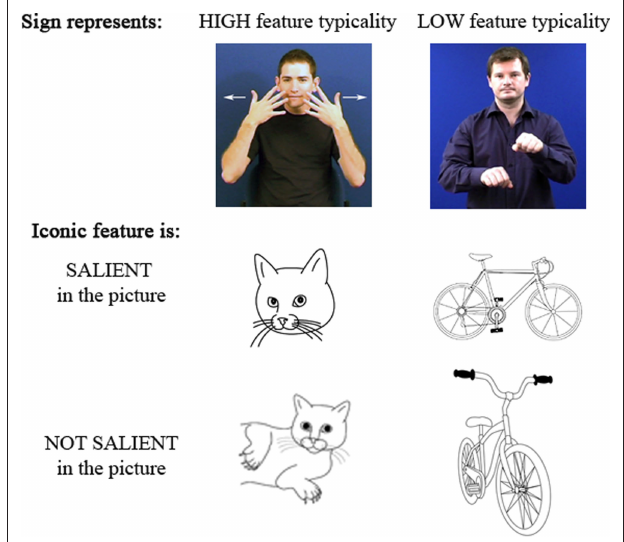
FigurE 4 | Still image for BSL signs cat (upper left) and bicycle (upper right). Pictures reflecting the iconic property saliently appear in the middle panels; pictures in which the iconic property is not salient appear in the lower panels. The sign for cat, indicating the whiskers on a cat’s face, depicts a typical feature, while the sign for bicycle, showing the pedals (moving in a circular motion) does